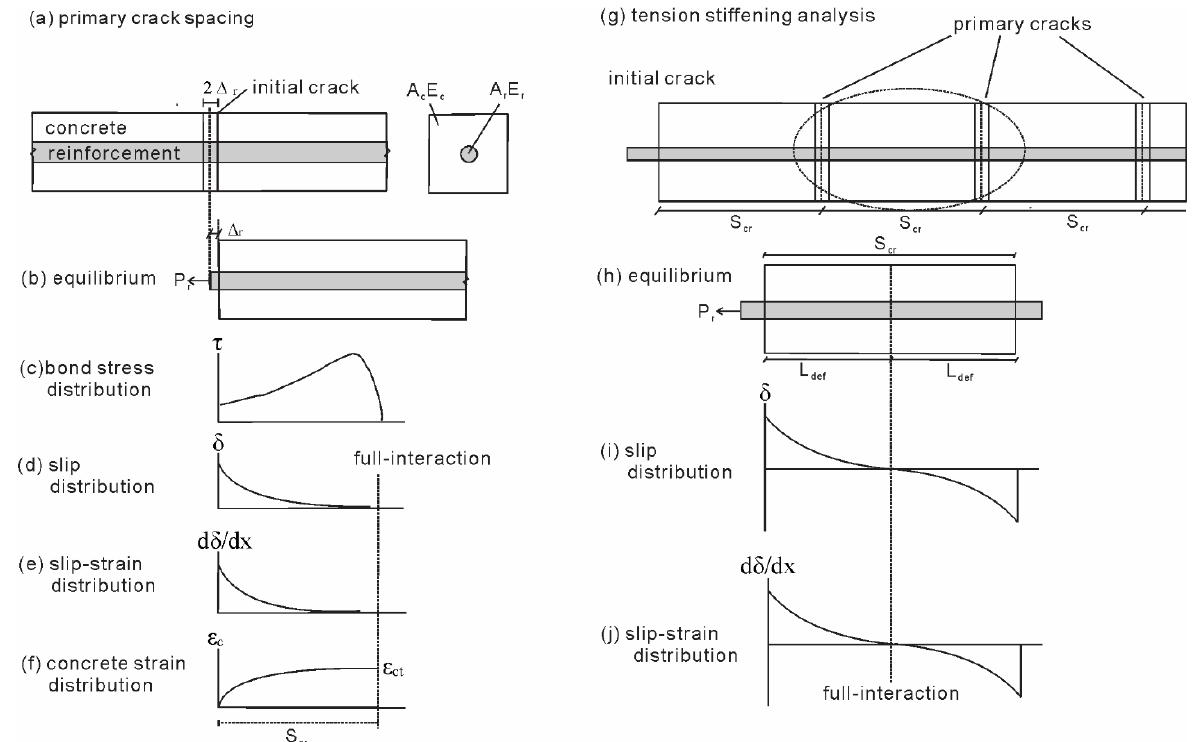
Figure 2. Partial interaction analyses. ( a ) Primary crack spacing; ( b ) Equilibrium; ( c ) Bond stress distribution; ( d ) Slip distribution; ( e ) Slip-strain distribution; ( f ) Concrete strain distribution; ( g ) Tension stiffening analysis; ( h ) Equilibrium; ( i ) Slip distribution; ( j ) Slip-strain